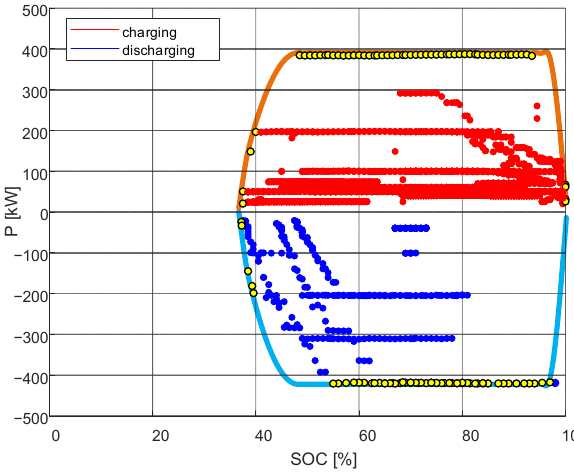
Figure 5. The result of the approximation of the results with the 1 min data polynomial function. The final characteristics determined on the basis of 1 min data are as in Figure 6. Energies 2020 , 13 , x FOR PEER REVIEW